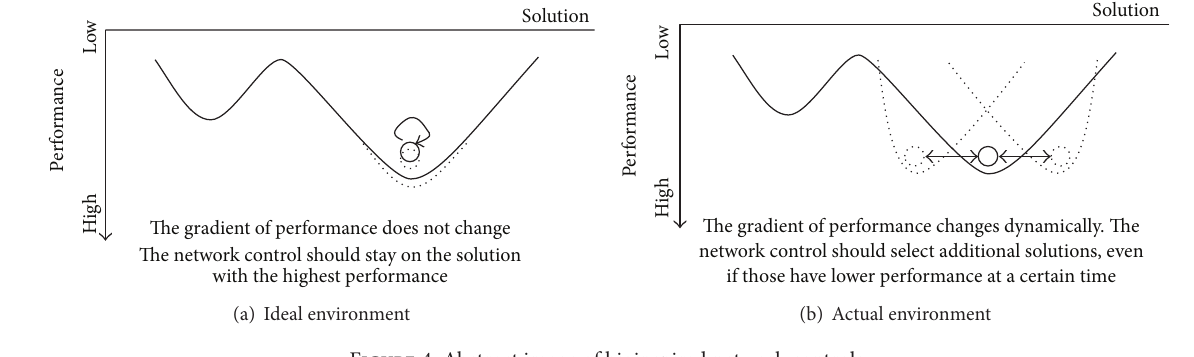
Figure 4: Abstract image of bioinspired network controls.